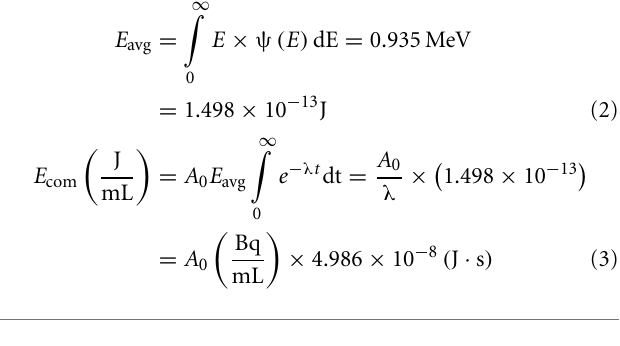
Table 2 | Published 90 Y pet phantom imaging summary